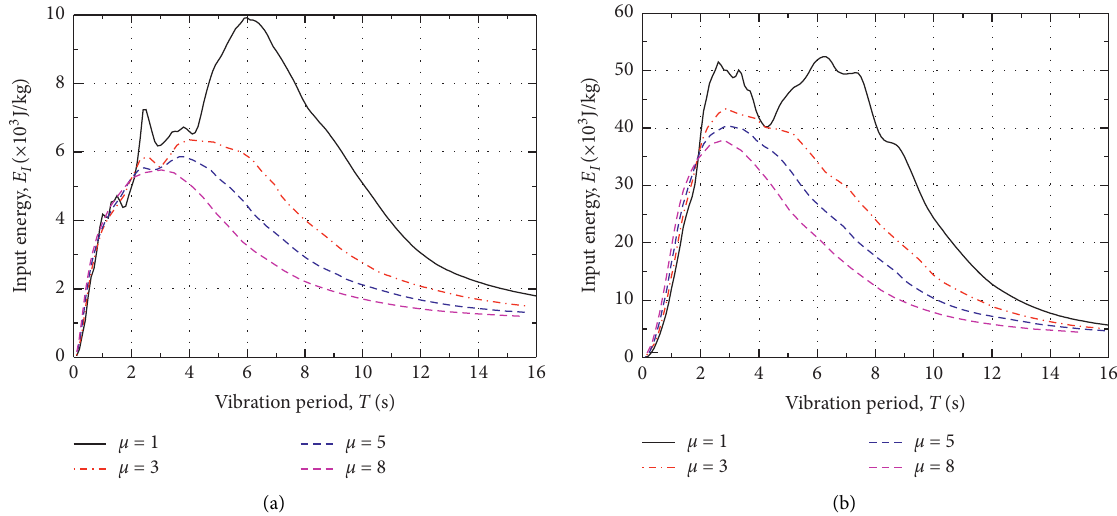
Figure 14: Input energy spectra affected by ductility coefficient. (a) Near-fault pulse-like ground motions. (b) Far-field harmonic ground motions.